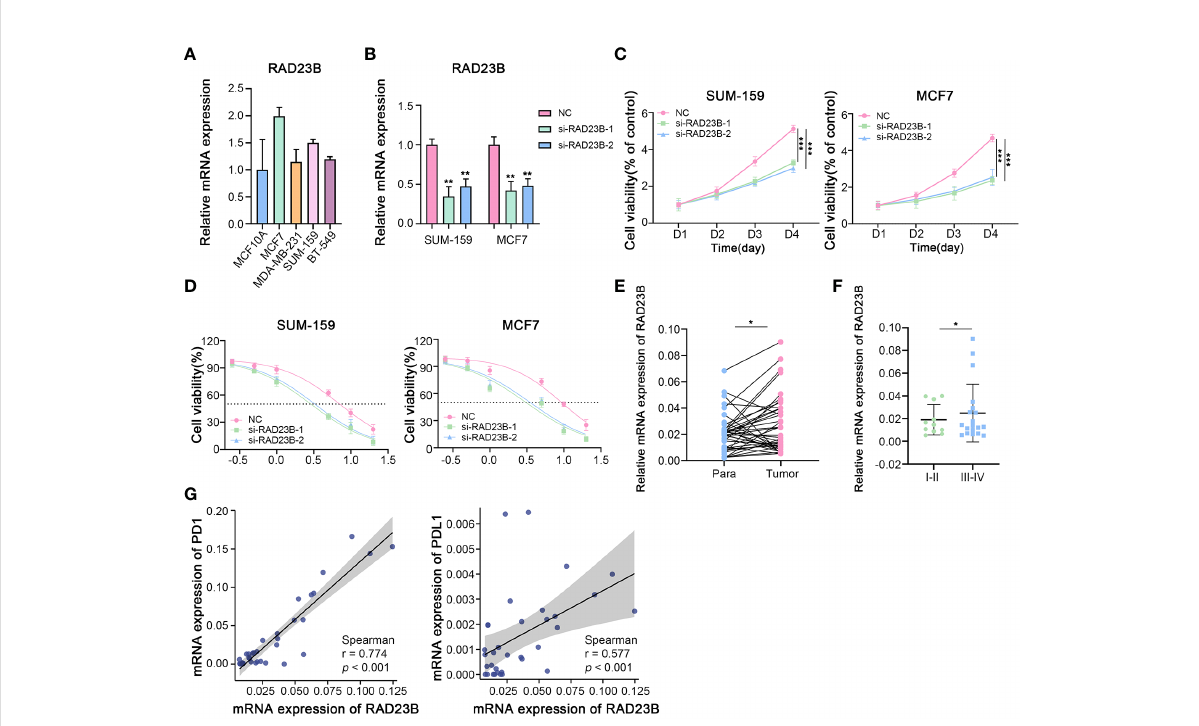
FIGURE 11 The Role of RAD23B in the Regulation of the Breast Cancer Progression, Chemotherapy and Immunotherapy in Vitro . (A) The mRNA expression levels of RAD23B in different breast cancer cell lines (RT-PCR). (B) The relative mRNA expression of RAD23B in SUM-159 and MCF7 breast cancer cells (RT-PCR; One-way ANOVA). (C) The cell viability assay after RAD23B reduction in SUM-159 and MCF7 breast cancer cells (MTT; Two-way ANOVA). (D) The IC50 of Paclitaxel after RAD23B reduction in SUM-159 and MCF7 breast cancer cells (MTT). (E) The relative mRNA expression of RAD23B in 34 pairs of breast cancer tissues and adjacent normal breast tissues (RT-PCR; Student ’ st-test). (F) The relative mRNA expression of RAD23B in different pathologic stages of breast cancer tissues (RT-PCR; Student ’ st-test). (G) Correlation between RAD23B mRNA expression and PD1/PDL1 mRNA expression (RT-PCR; Spearman test). * p < 0.05, ** p < 0.01, *** p <